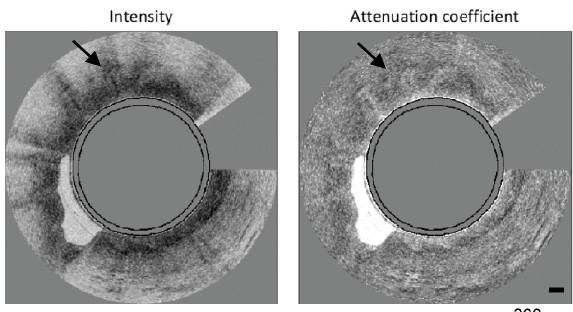
Fig. 2. Cross section frame from a distal location along the pullback. Intensity OCT B-scan and corresponding AC image.